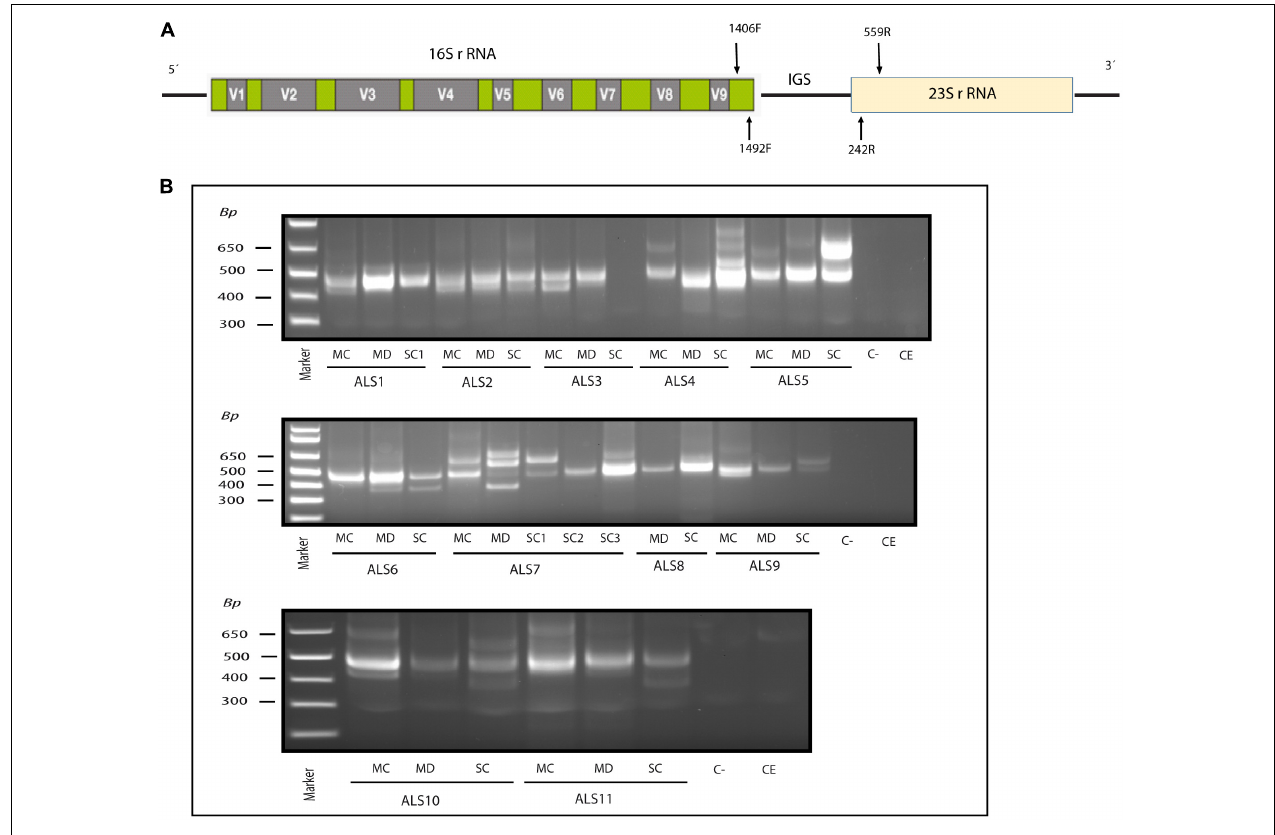
FIGURE 1 | Nested PCR analysis of bacterial DNA extracted from patients with ALS. PCR analysis was carried out as described in section Materials and Methods. (A) Schematic representation of bacterial rRNA genes (16S and 23S) and the intergenic sequence (IGS) region, including the location of the primers employed for the different reactions. (B) Agarose gel electrophoresis of the DNA fragments amplified by nested PCR; analysis of three CNS regions (MC, MD, and SC) from 11 patients amplifying the IGS region Primers 1406(F) – 559(R) and 1492 (F) –242 (R) were used in the first and second round PCR, respectively, C-, control PCR without DNA; CE, control of DNA extraction without DNA; MC, motor cortex; MD, medulla; SC, spinal cord; SC1, SC2, and SC3, three samples from different regions of the spinal